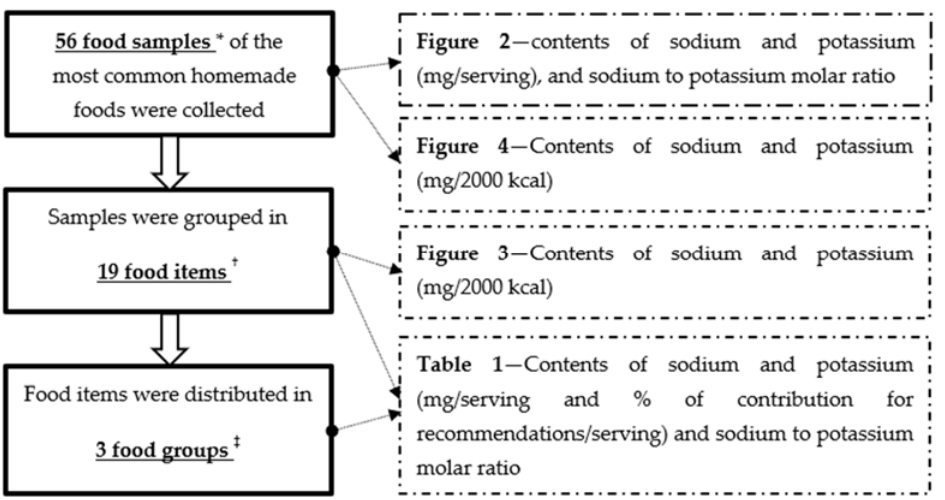
Figure 1. Flow chart of the data analysis process. * Two aliquots from each sample were analysed (bromatological analysis). The mean of the two values was used for data analyses considering each of the 56 samples. † The mean of the values obtained from the individual samples of each food item was computed. ‡ The mean of the values obtained from the individual samples of foods pertaining to each food group was computed.